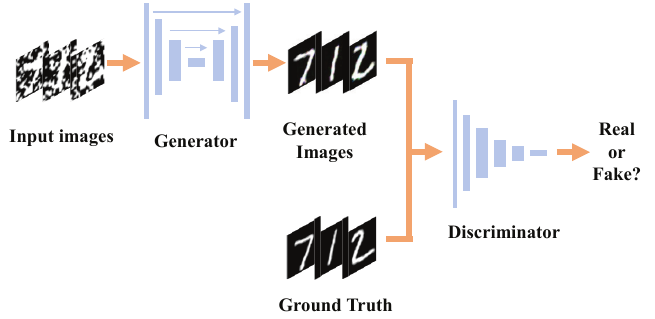
Figure 2. Schematic illustration of the training pipeline of deep learning ghost imaging.